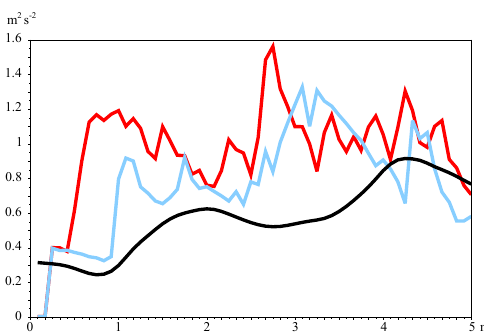
-0.4 Figure 10. Fine Meso-NH TKE in black and particle TKE in red, for one cell of the fine grid. The gray area represents the standard deviation of the particle TKE for the particles in the cell.